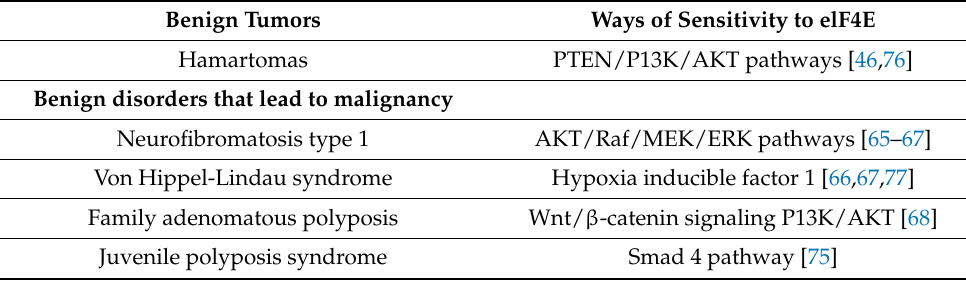
Table 2. Disorders related to loss of function of mTOR activity. Benign Tumors Ways of Sensitivity to